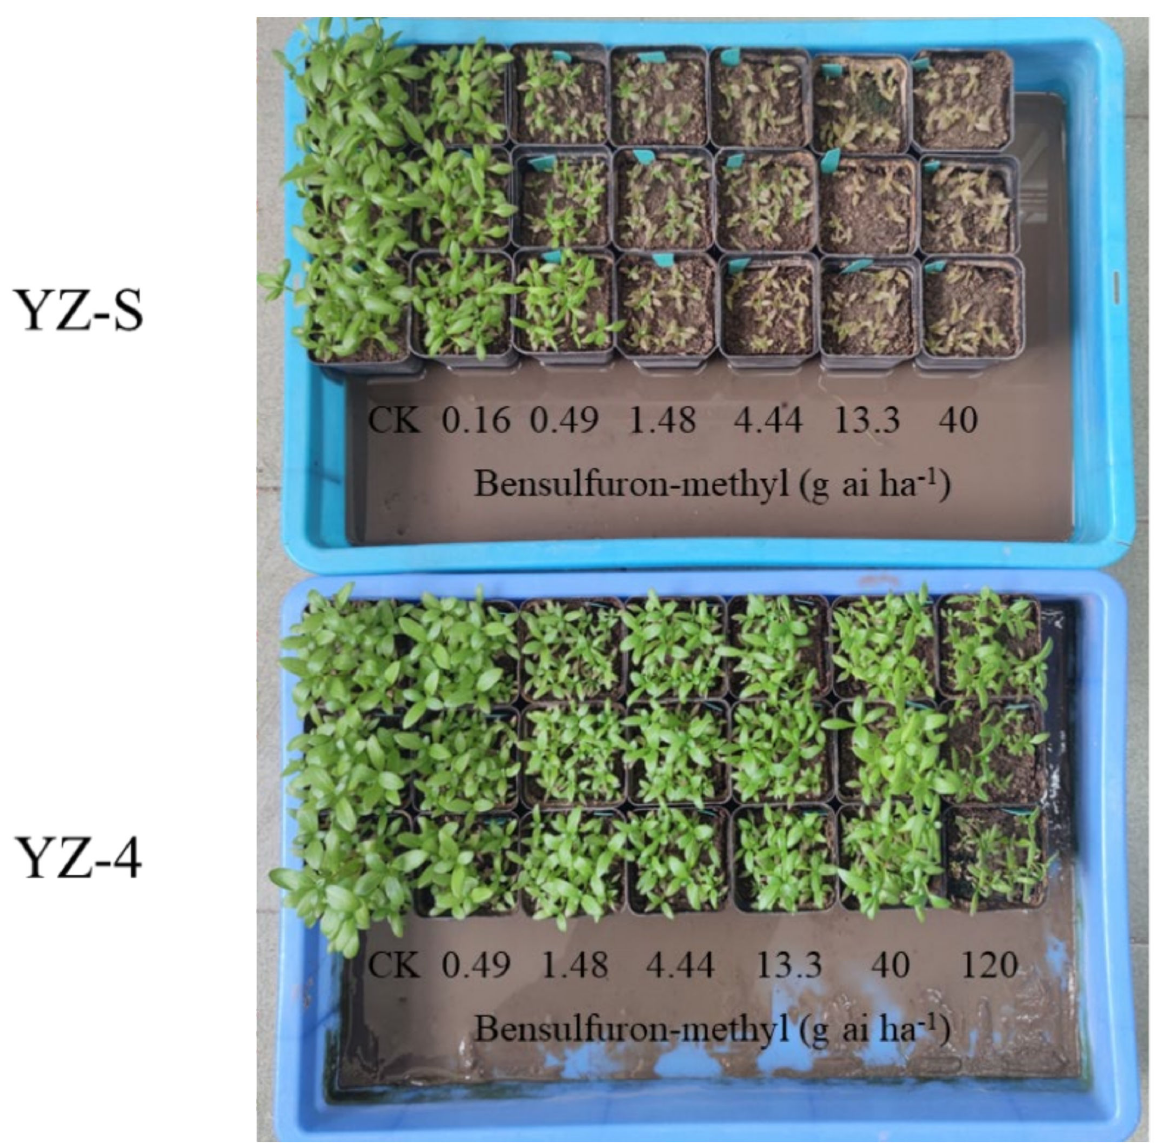
Figure 1. Growth status of YZ-S and -4 A. auriculata plants 21 days after bensulfuron-methyl